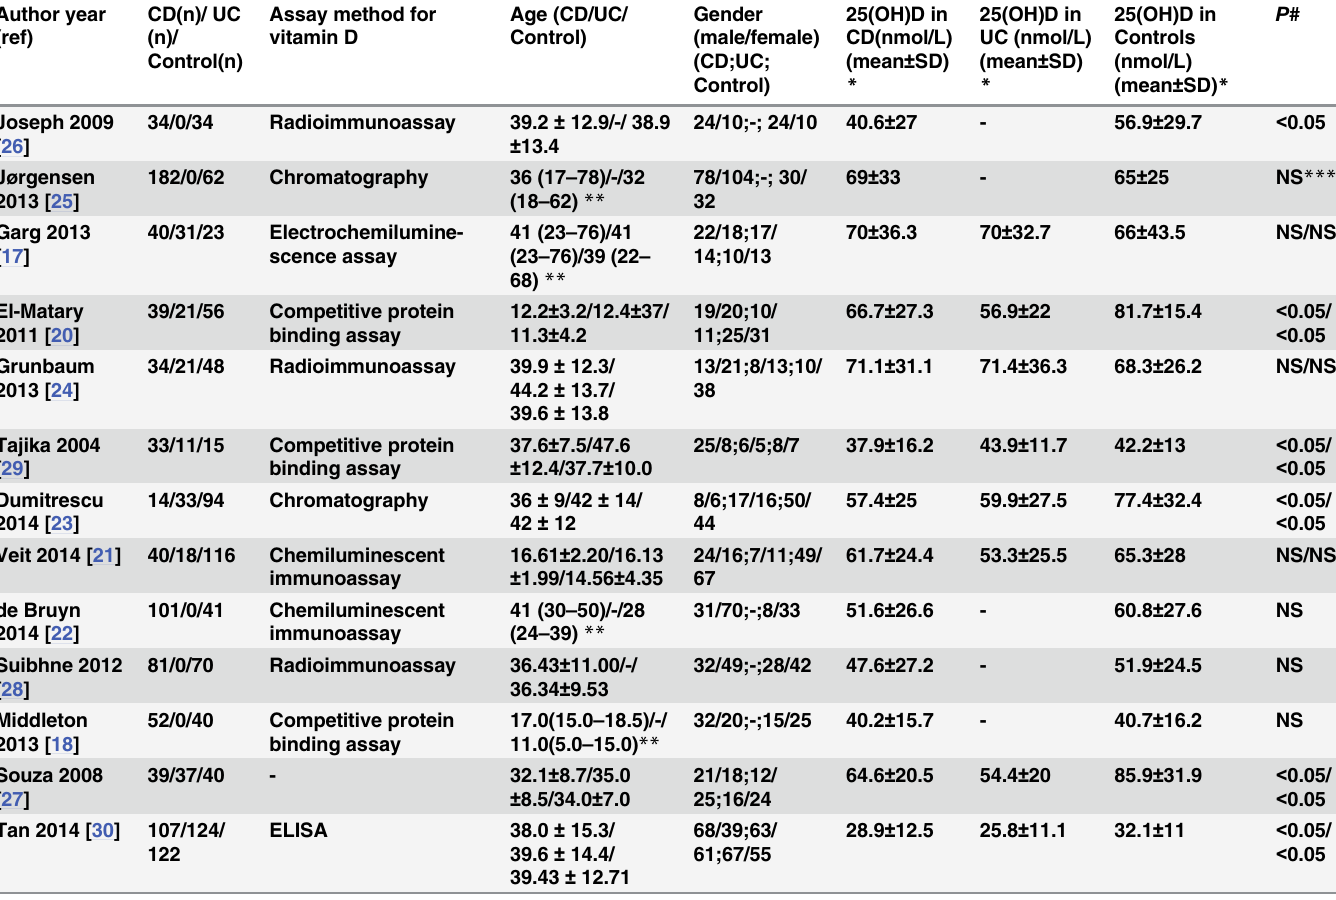
Table 1. Studies on vitamin D levels in CD patients, UC patients, and